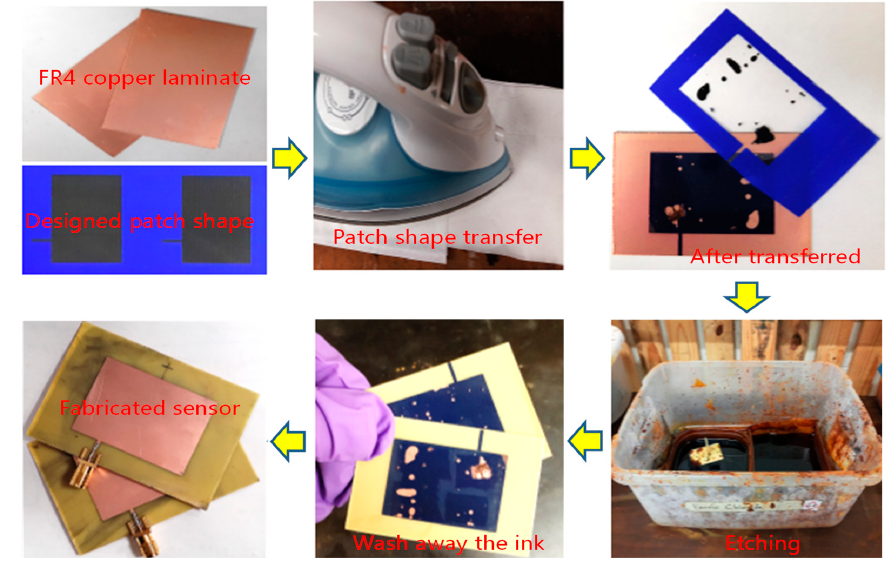
Figure 10. Fabricating process of the antenna sensor.